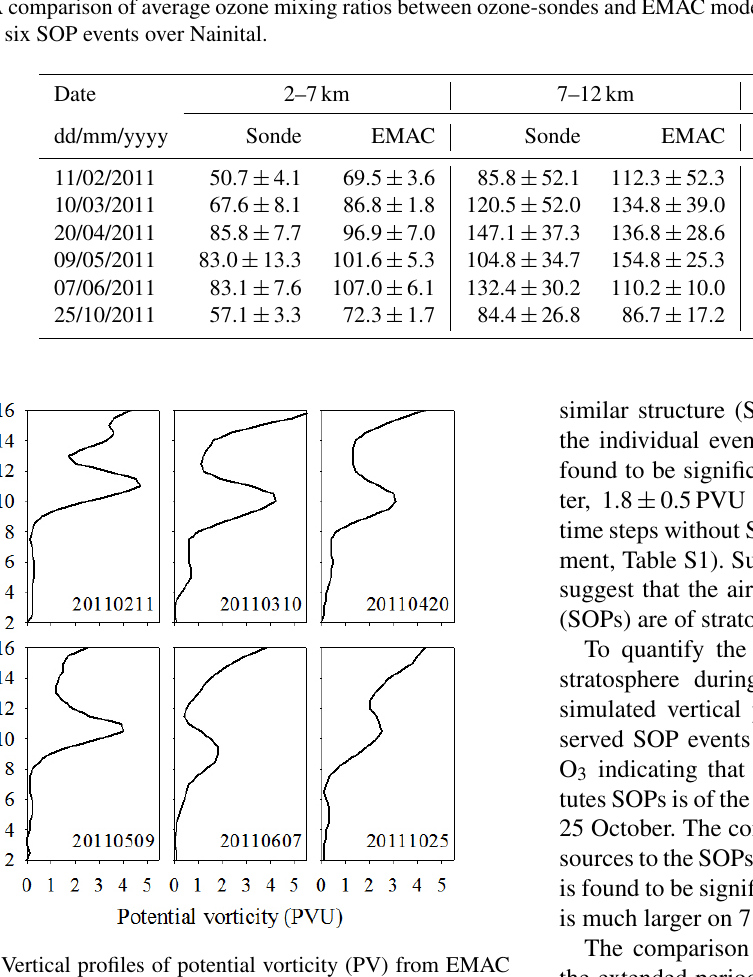
Figure 3. Vertical profiles of potential vorticity (PV) from EMAC simulations during the SOPs over